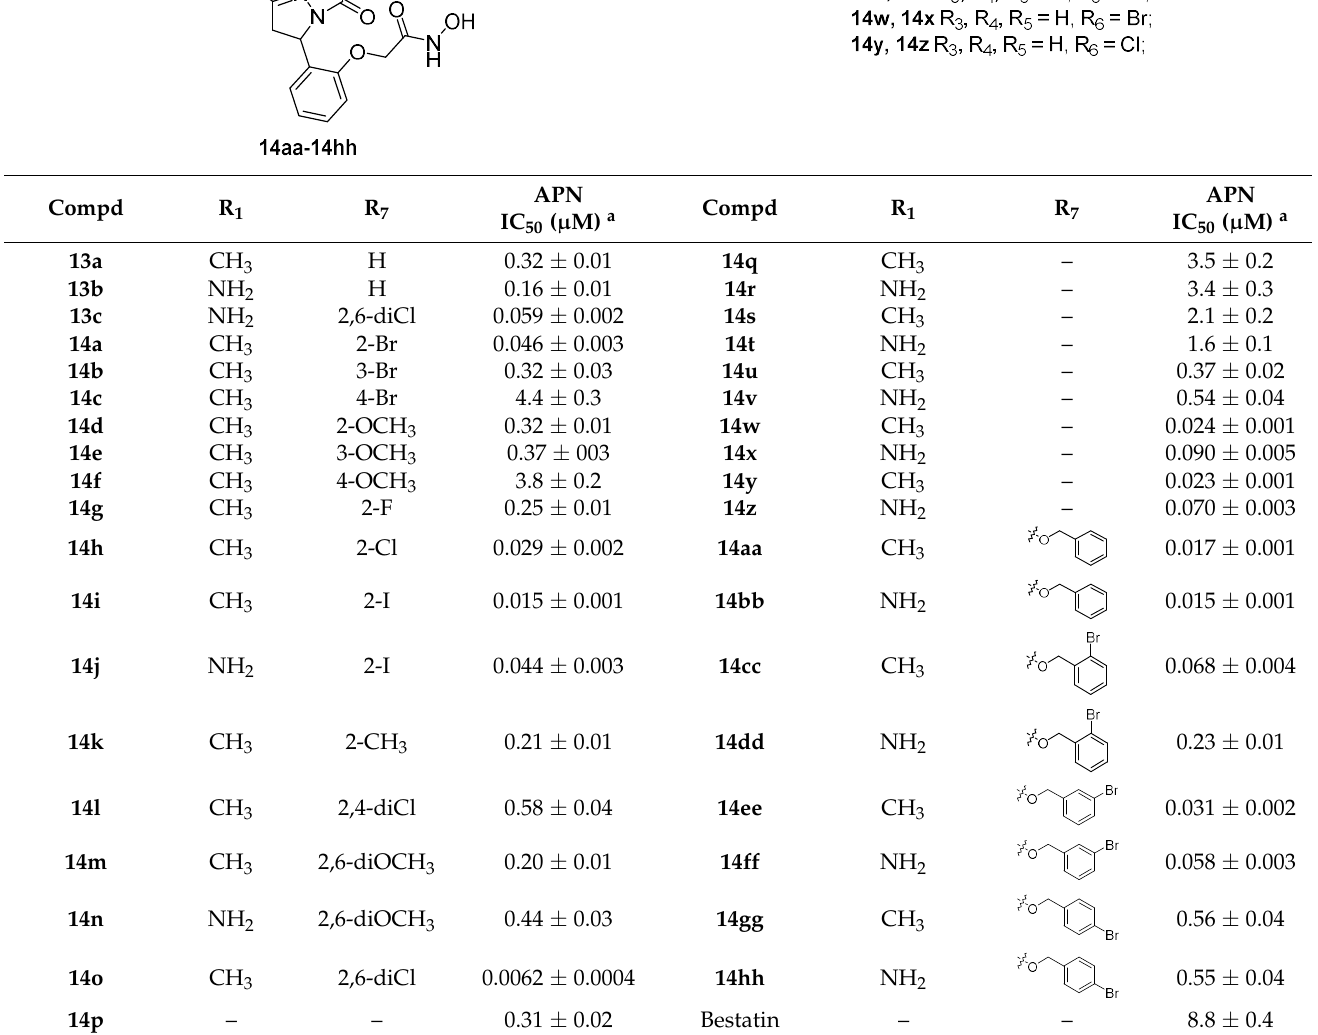
Table 2. In vitro anti-proliferative activities of selected compounds against tumor cells. Com- pound